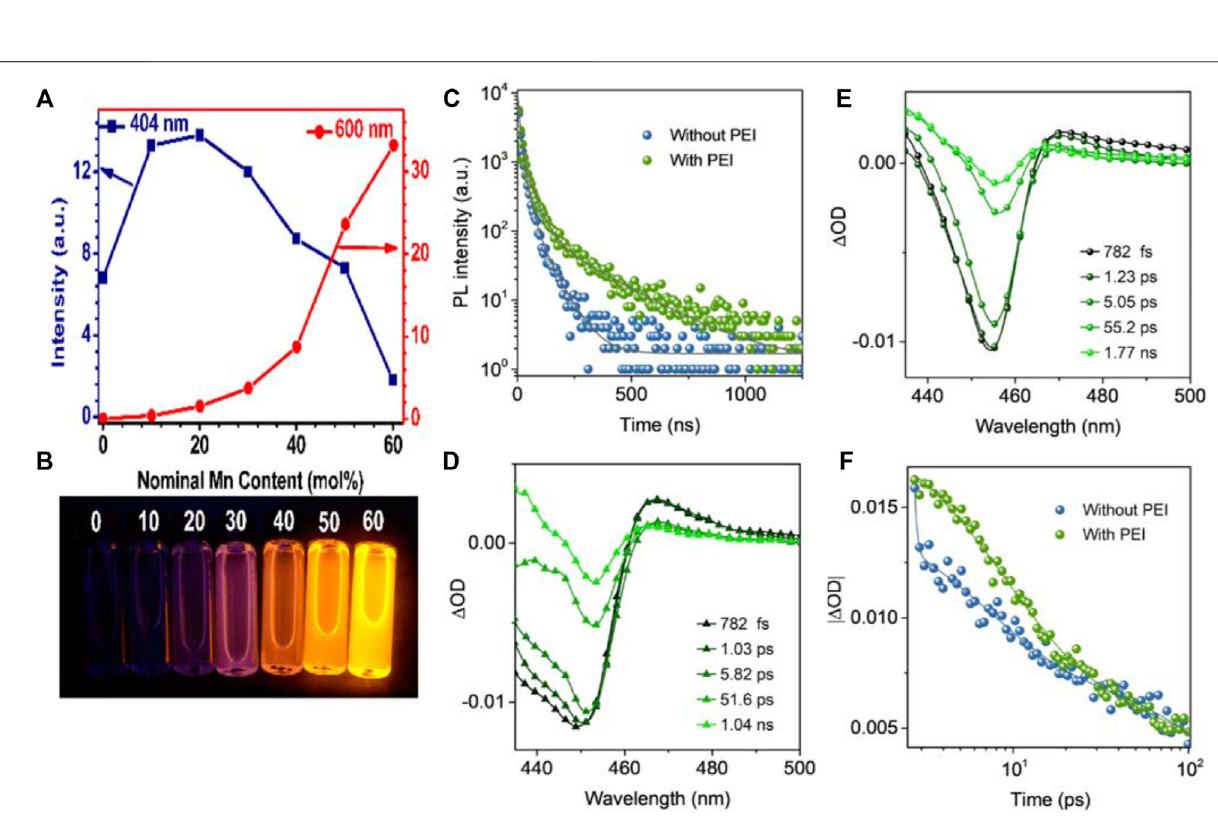
Frontiers in Materials |